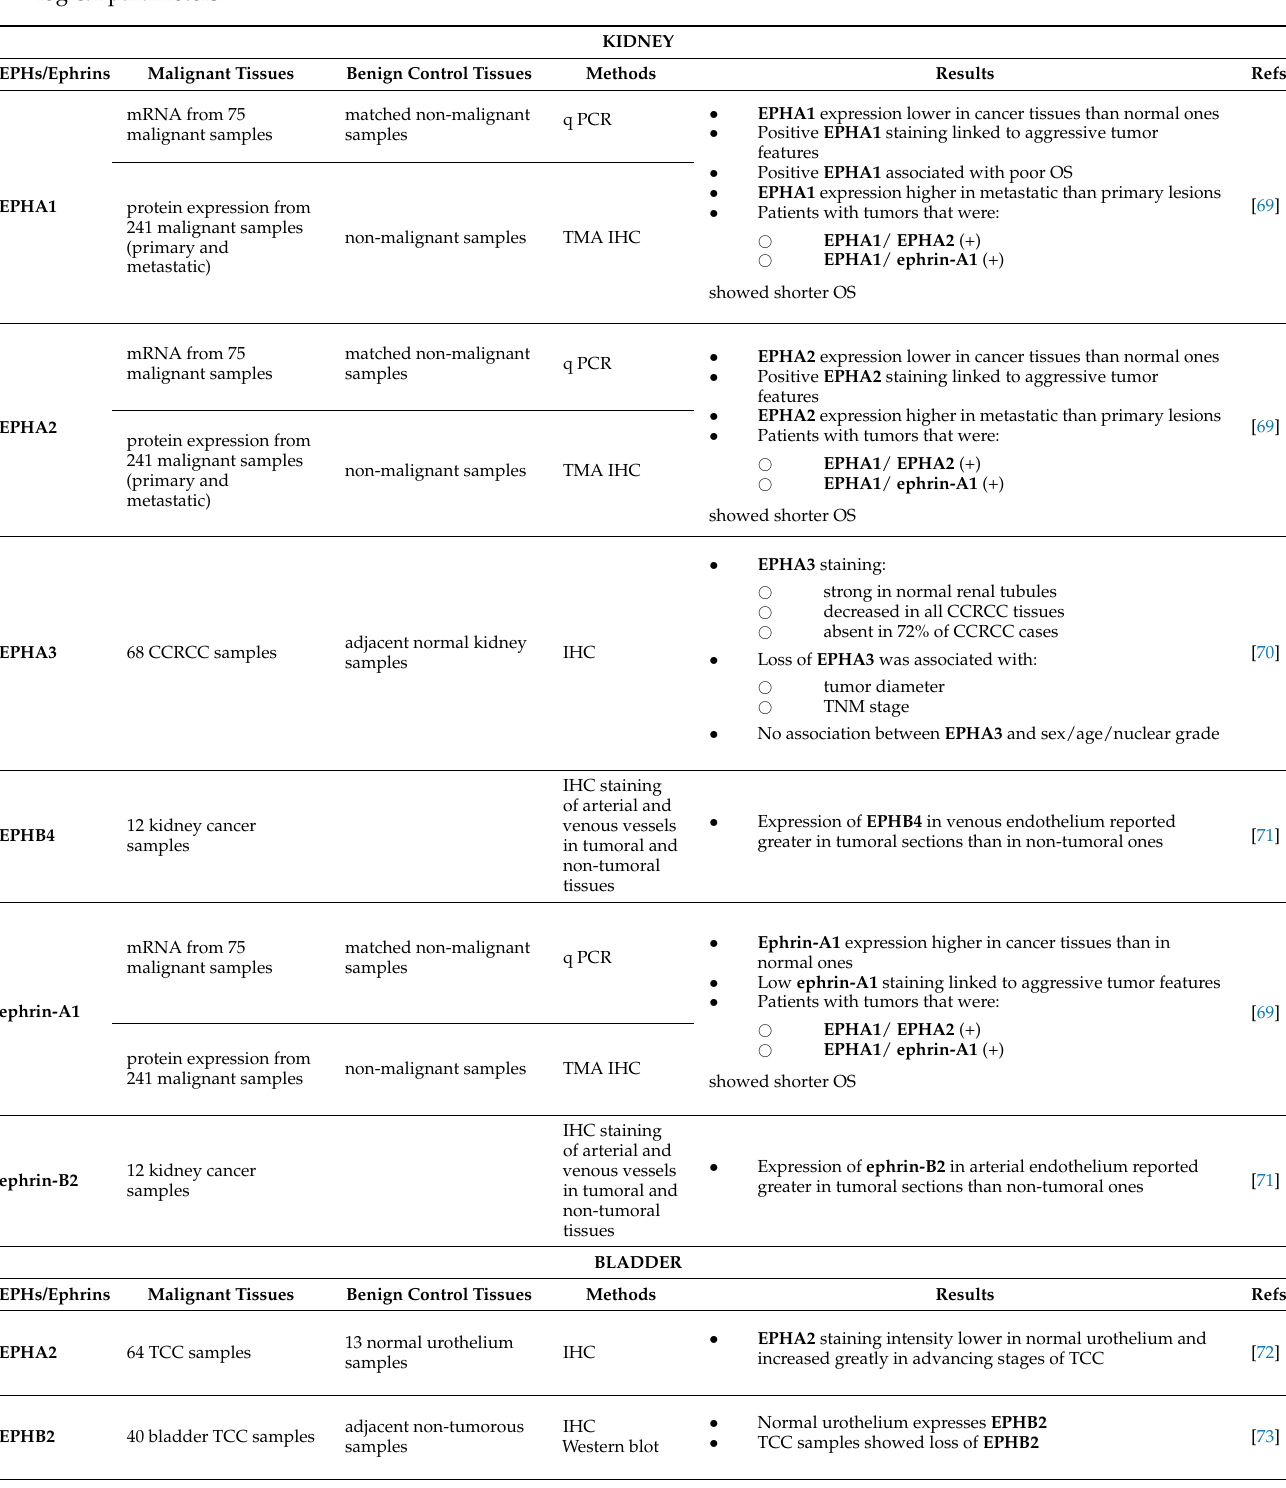
Table 4. EPHs/ephrins (bold) studied in solid tumors of the urinary tract and prostate and correlations with clinicopatho- logical